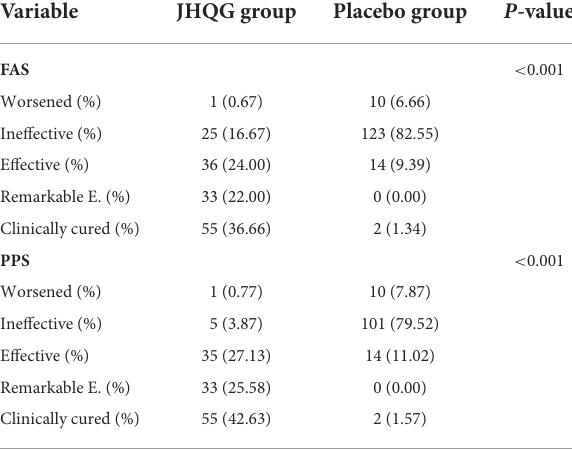
TABLE 5 Curative index analysis